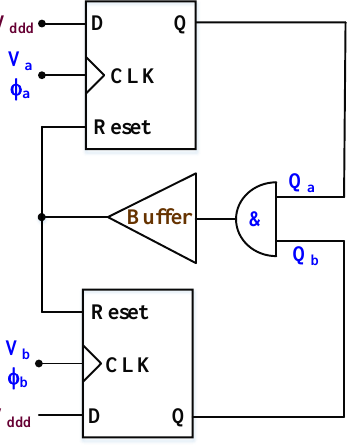
Figure 13. Adopted PFD with two DFFs, a buffer, and an AND gate.